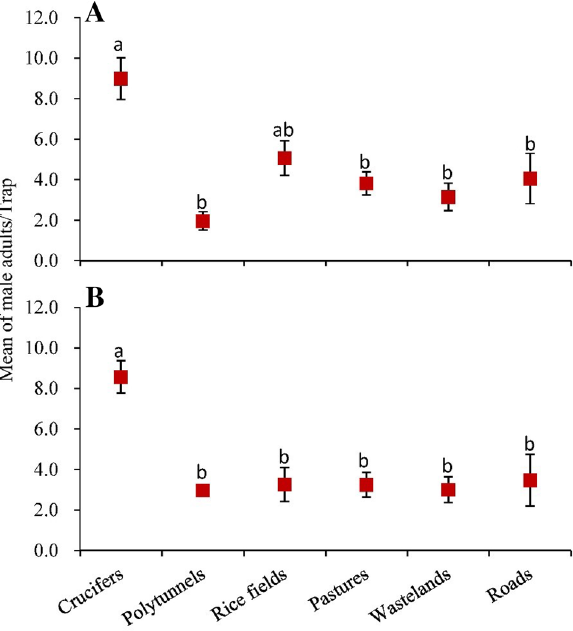
Figure 6. Mean number of P . xylostella adults (± SE) per trap during 2 years survey, collected on the main landscape elements where traps were positioned. Means with the same letter are not significantly different by Tukey–Kramer test ( P = 0.05). ( A ) The first year (from 30 October 2015 to 27 September 2016), ( B ) The second year (from 7 October 2016 to 17 September 17